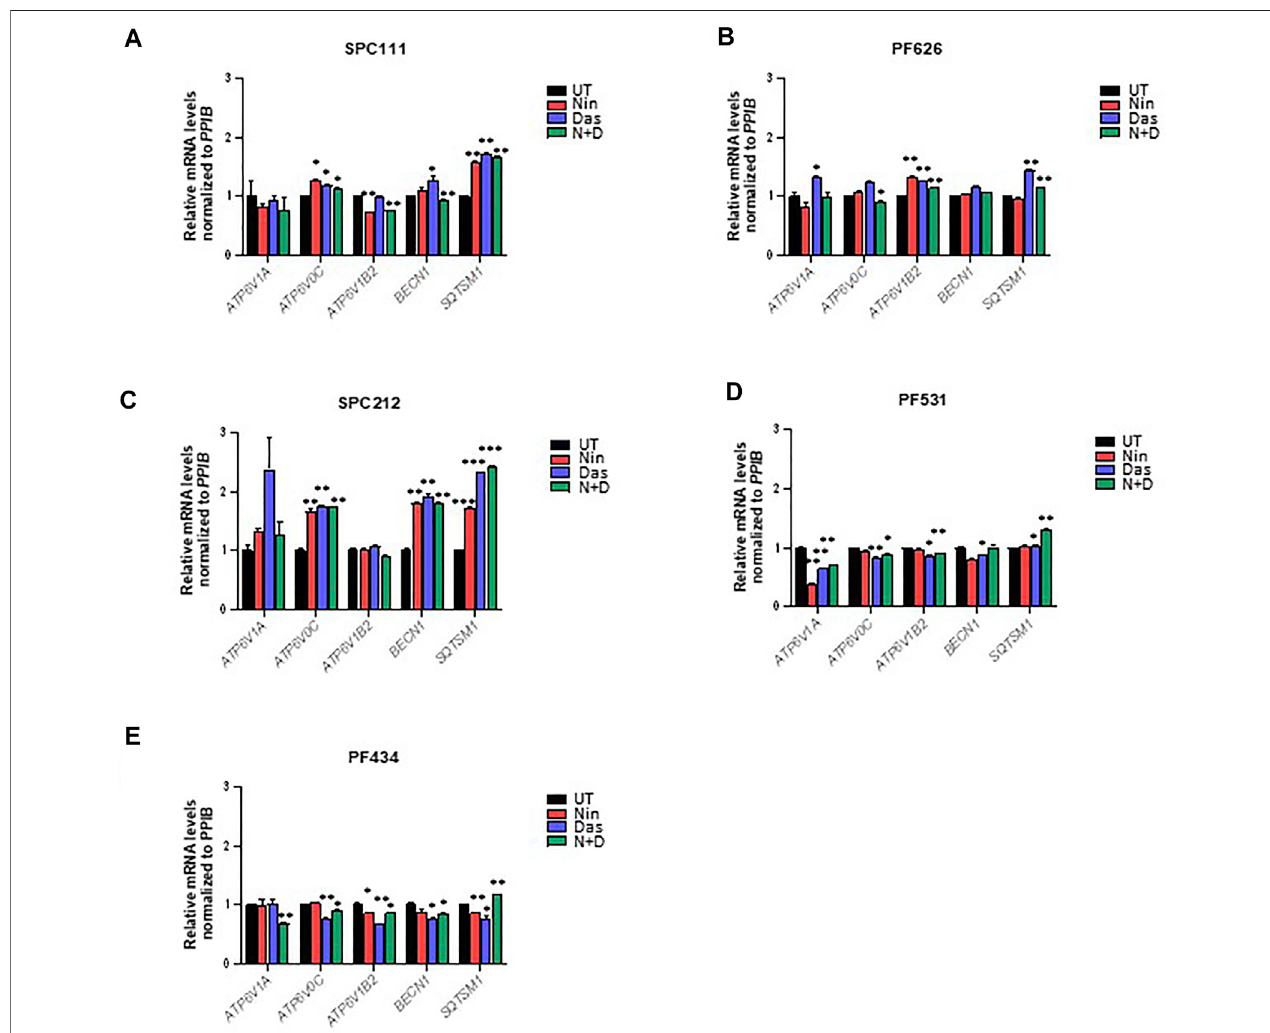
FIGURE 7 | TFEB target genes are only induced in some MPM cell lines upon dasatinib and nintedanib treatments. Expression of the indicated TFEB target genes wasanalyzedbyqRT-PCRaftertreatment for24 hof50 nMdasatiniband1 μ Mnintedanibin (A) SPC111, (B) PF626, (C) SPC212, (D) PF531,and (E) PF434celllines. UT, untreated (DMSO) control; Nin, nintedanib; Das, dasatinib; N +D, combination ofnintedanib and dasatinib. Bars are average ±SEM. *, p < 0.05; **, p < 0.01; ***, p < 0.001, t -test.